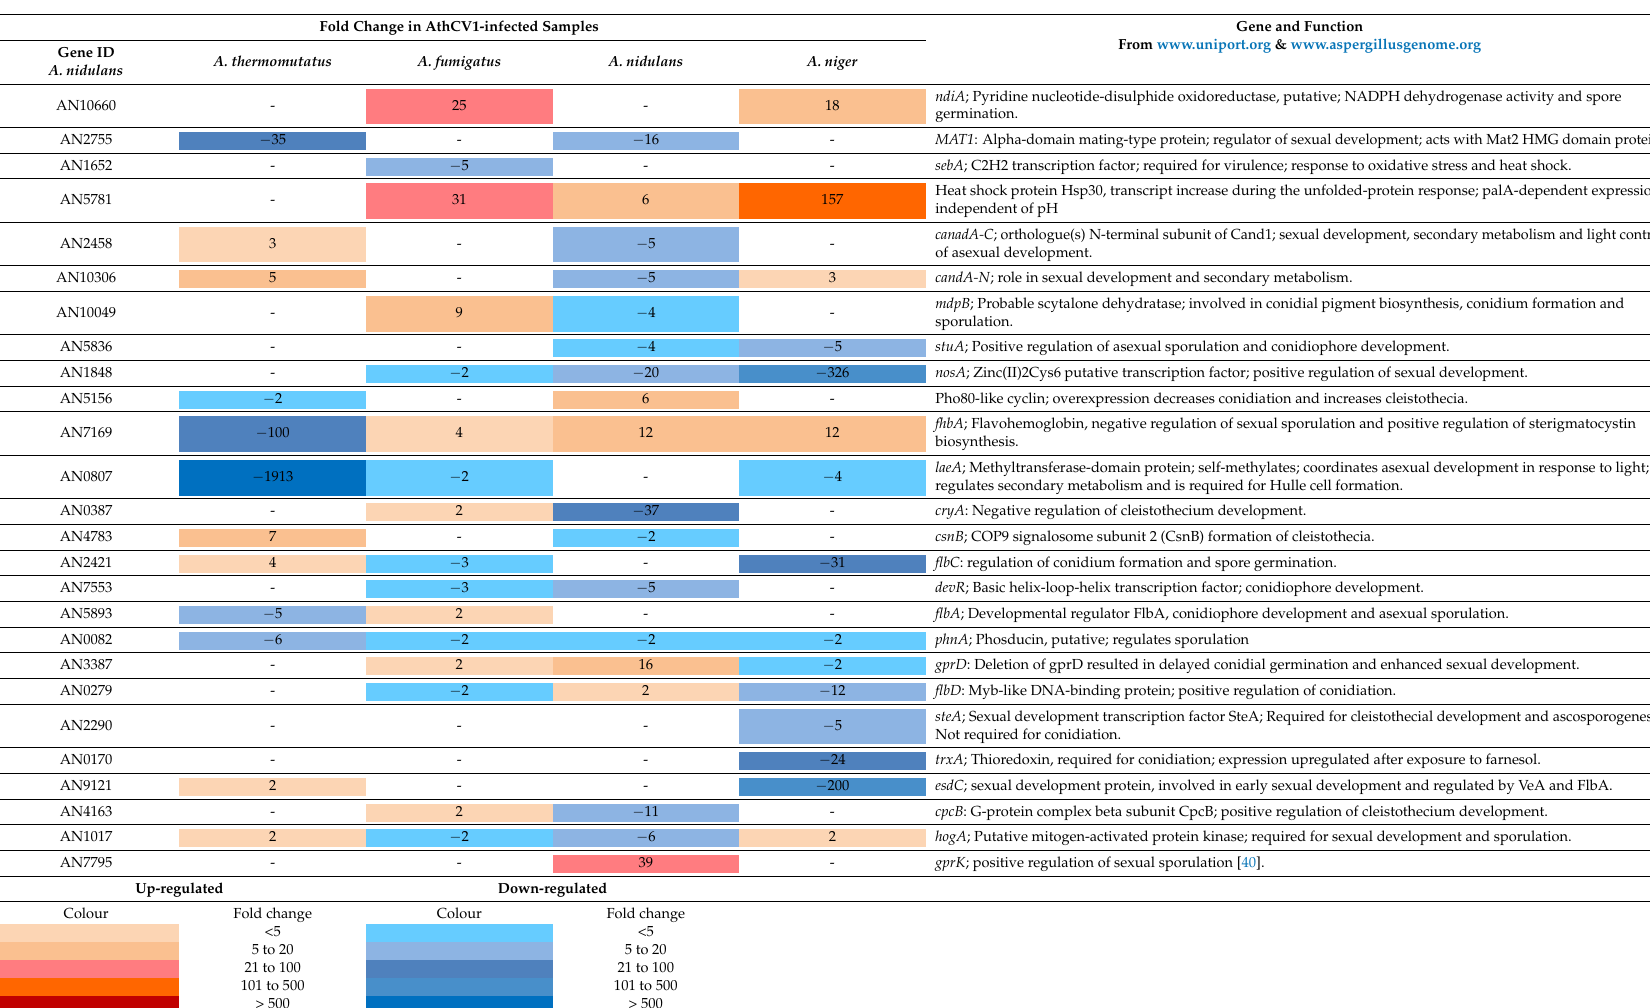
Table 3. Major changes in the expression of gene orthologues of AthCV1-infected Aspergillus species compared to their isogenic AthCV1-free lines. FoldChangeinAthCV1-infectedSamples